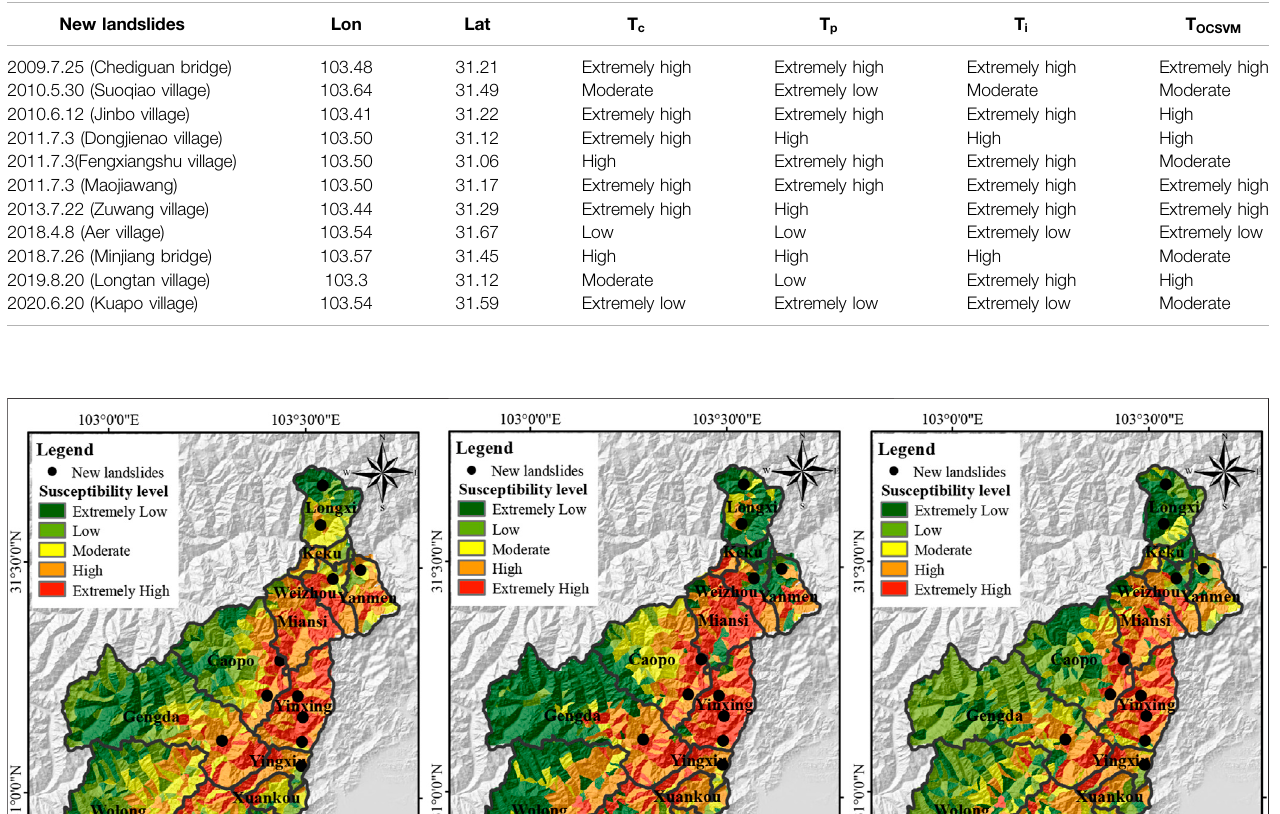
TABLE 5 | LSM and new landslide events.